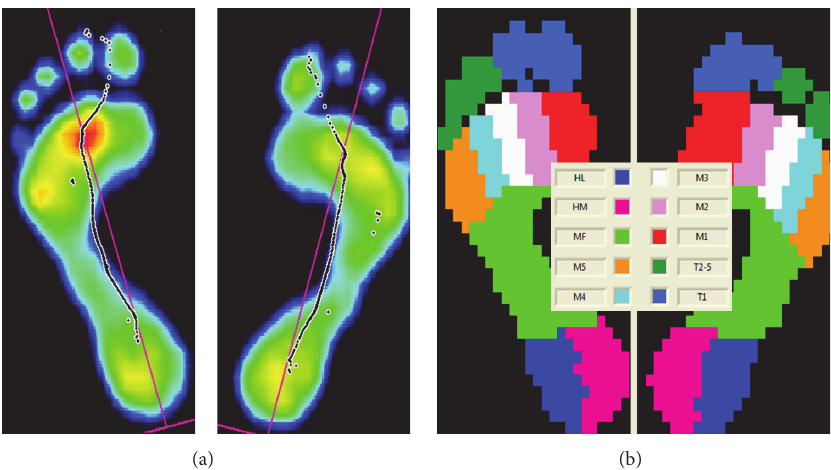
Figure 1: (a) Sample typical peak pressure image for a normal foot and (b) selection of anatomical zones in the Footscan software (HL: heel lateral; HM: heel medial; T1: big toe; T2–5: toes 2–5; M1, 2, 3, 4, and 5: metacarpals 1, 2, 3, 4, and 5).